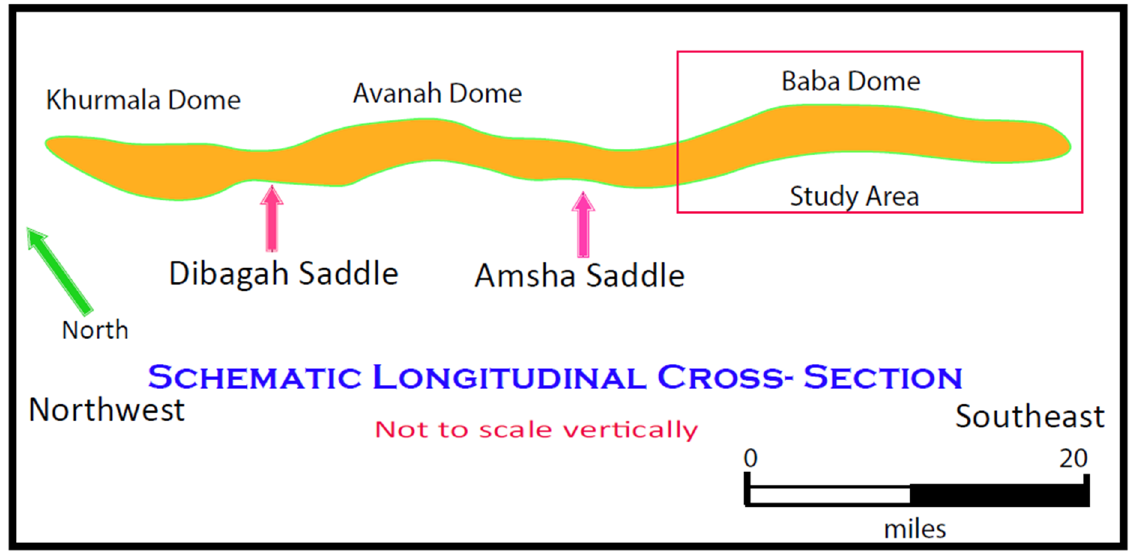
Figure 1. Schematic longitudinal cross-section of the Kirkuk structure (after Dunnington, 1958) including the area from which the samples are recovered.